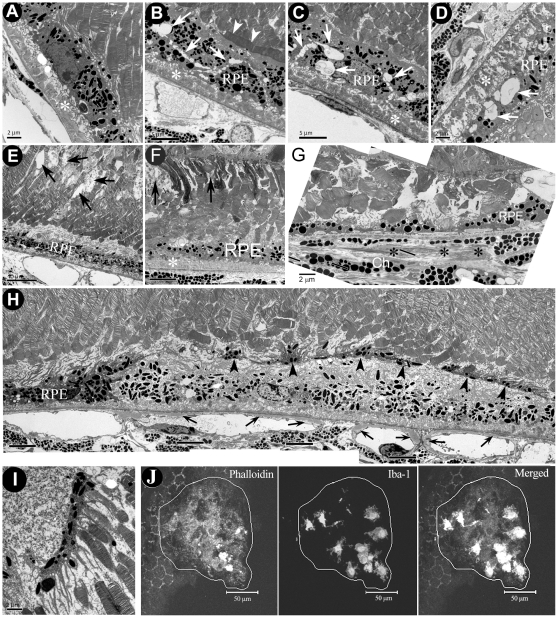
TEM images of RPE/photoreceptor of different strains of mice.A, an image from a 22-month old WT mouse showing RPE basal laminar deposits (asterisk). B, an image from 22-month old CCR2 KO mouse showing a photoreceptor outer segment (arrowhead) in parallel with RPE cells, multiple vacuoles (white arrows) in RPE cells and basal laminar deposits (asterisk). C, an image from a 22-month old CCL2 KO mouse showing multiple vacuoles in RPE cells (white arrows) and basal laminar deposits (asterisk). D, an image from a 24-month old CCL2 KO mouse showing multiple vacuoles and reduced melanin granules in degenerated RPE cells, basal laminar deposits (asterisk). E, an image from a 24-month old CCR2 KO mouse showing photoreceptor inner segment degeneration (black arrows), and a gap between RPE cells and photoreceptor outer segments. F, an image from a 20-month old CCL2 KO mouse showing photoreceptor inner segment degeneration (black arrows), reduced melanin granules in RPE cells and RPE basal laminar deposition (asterisk). G, an image from a 20-month old CCL2 KO mouse showing a patch of RPE atrophy, disorganised photoreceptor outer segments, a lack of choriocapillaris, and fibrotic tissues in the choroid (black asterisks). H and I, images from a 24-month old CCL2 KO mouse showing the loss of electron-dense materials in the cytoplasm, the loss of cytoplasm organelles and membrane, and a nucleus with reduced electron-dense materials in the RPE layer; choriocapillaris basal laminar deposition in the choroid; a layer of melanin granule-containing cells (block arrowheads) on top of the degenerated RPE cells with their process extending towards the photoreceptor outer segments. RPE, retinal pigment epithelia. (J), A confocal image of RPE/choroidal flatmount of a 24-month CCL2 KO mouse showing accumulation of macrophages/microglia at the site of RPE damage. RPE damages were highlighted with disorganised actins (phalloidin staining) and subretinal macrophages were labelled with Iba-1.